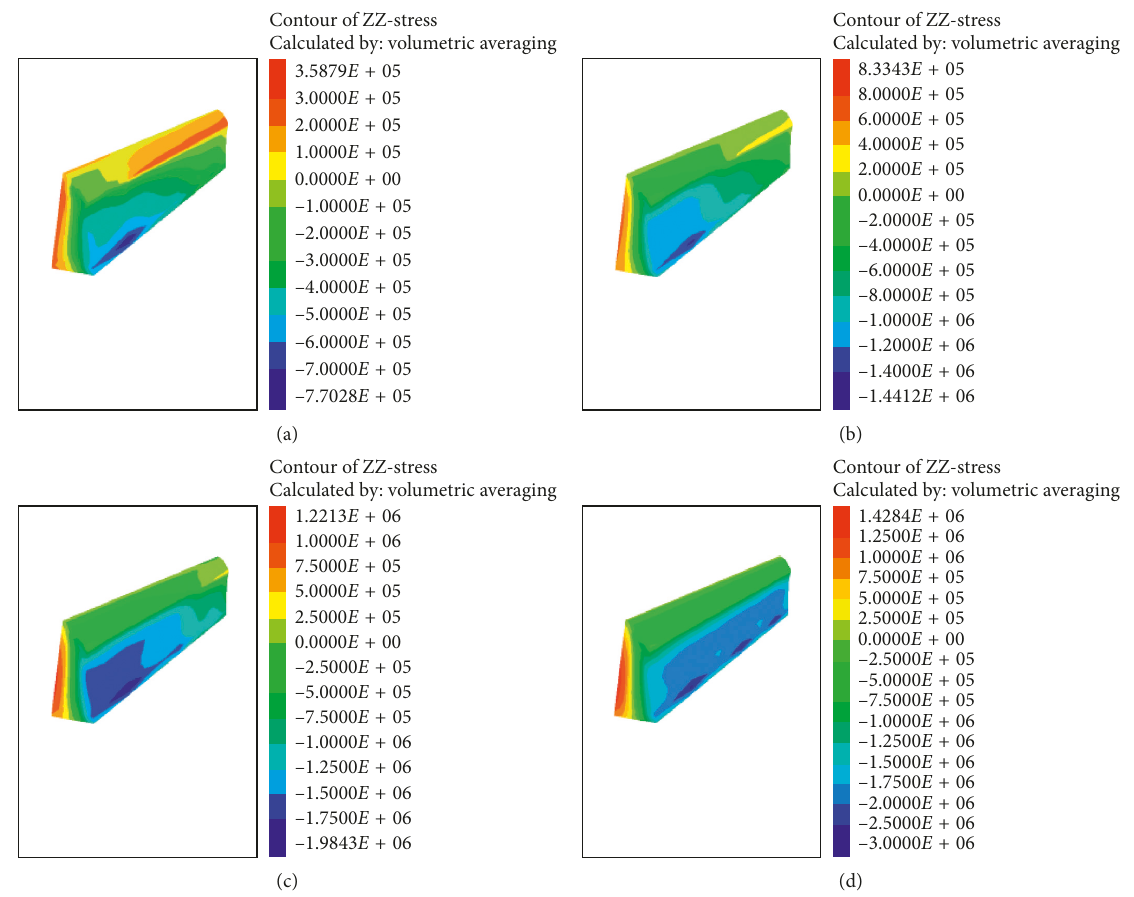
Figure 11: Vertical stress change of the retaining wall under different working conditions: (a) excavation of 3m; (b) excavation of 12m; (c) excavation of 21m; (d) excavation of 30m.